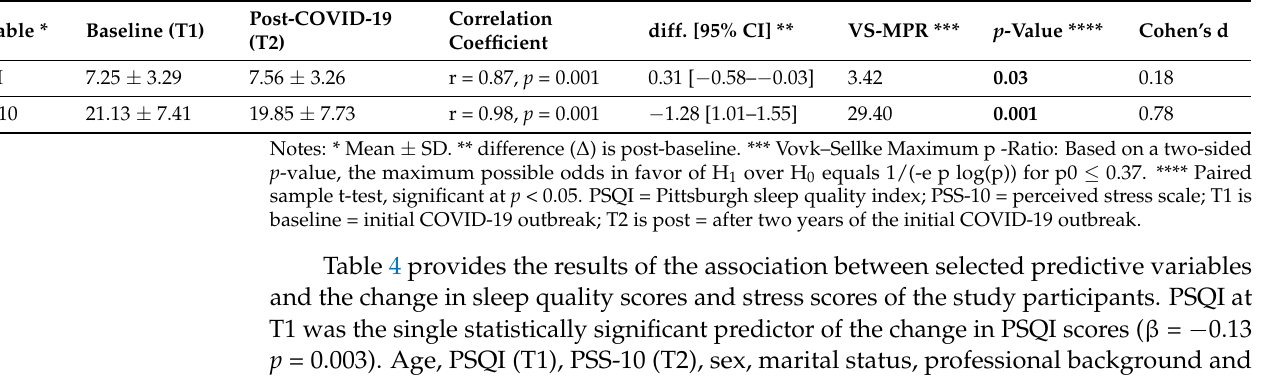
Table 3. Changes in sleep quality scores and stress scores of the study participants with difference expressed as post-COVID-19 minus baseline.